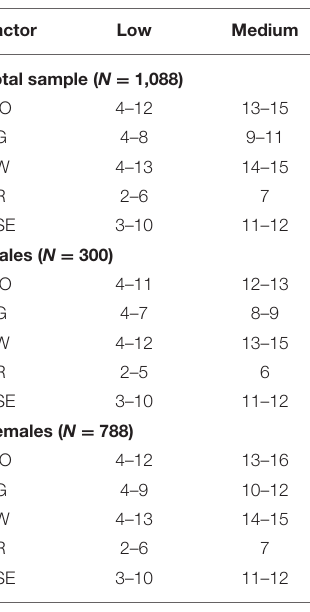
TABLE 8 | Scoring directions of